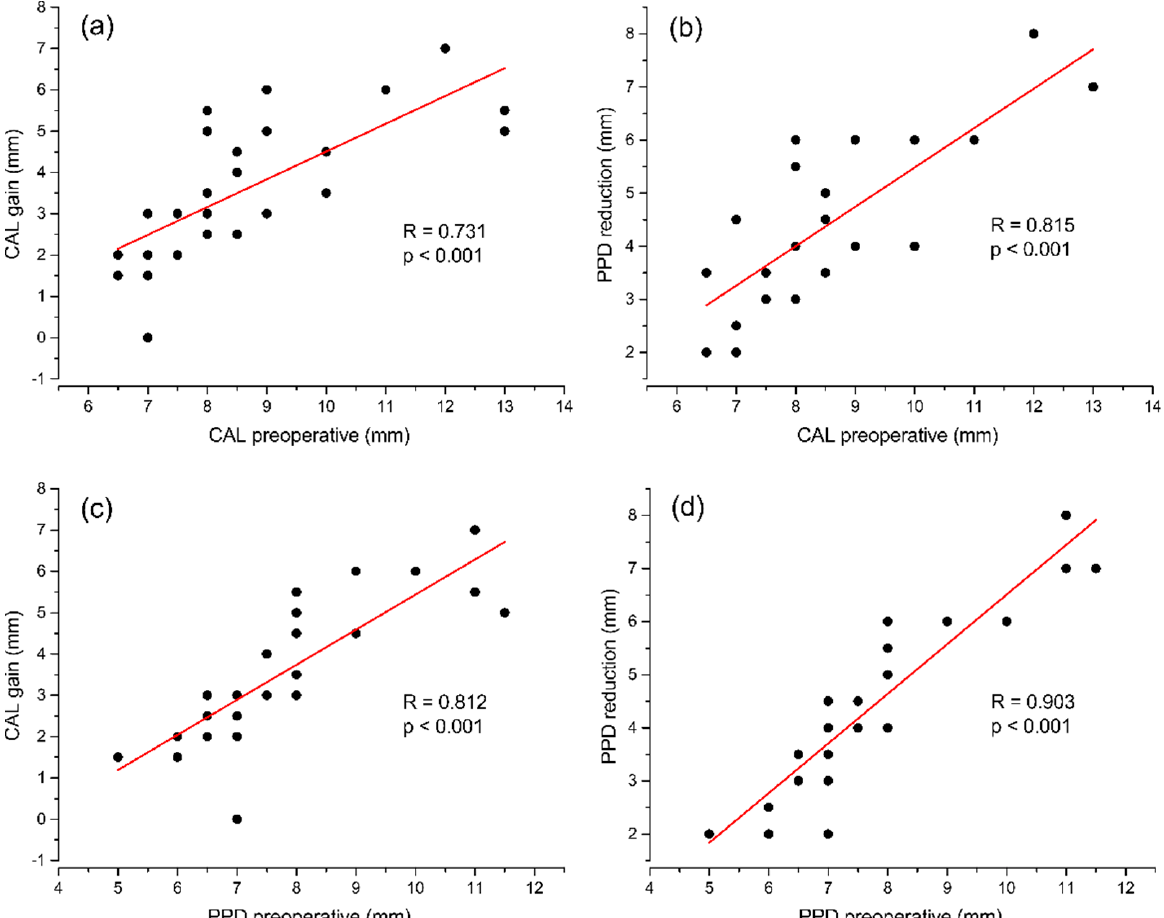
Figure 3. Correlations among interval variables. ( a ) CAL gain compared to preoperative CAL. ( b ) PPD reduction compared to preoperative CAL. ( c ) CAL gain compared to preoperative PPD. ( d ) PPD reduction compared to preoperative PPD.